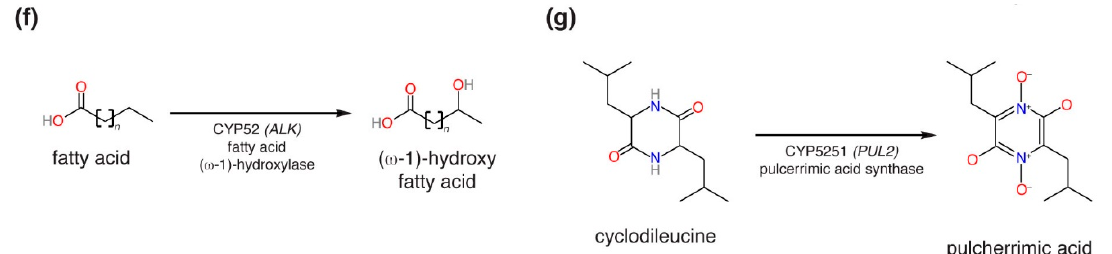
Figure 1. Currently known cytochrome P450 monooxygenase (CYP) enzymatic activities among budding yeasts: ( a ) Δ 22 -sterol desaturase; ( b ) 14 α -lanosterol demethylase; ( c ) N -formyl- L -tyrosine oxidase; ( d ) n -alkane hydroxylase; ( e ) fatty acid ω -hydroxylase; ( f ) fatty acid ( ω -1)-hydroxylase; ( g ) pulcherrimic acid synthase.